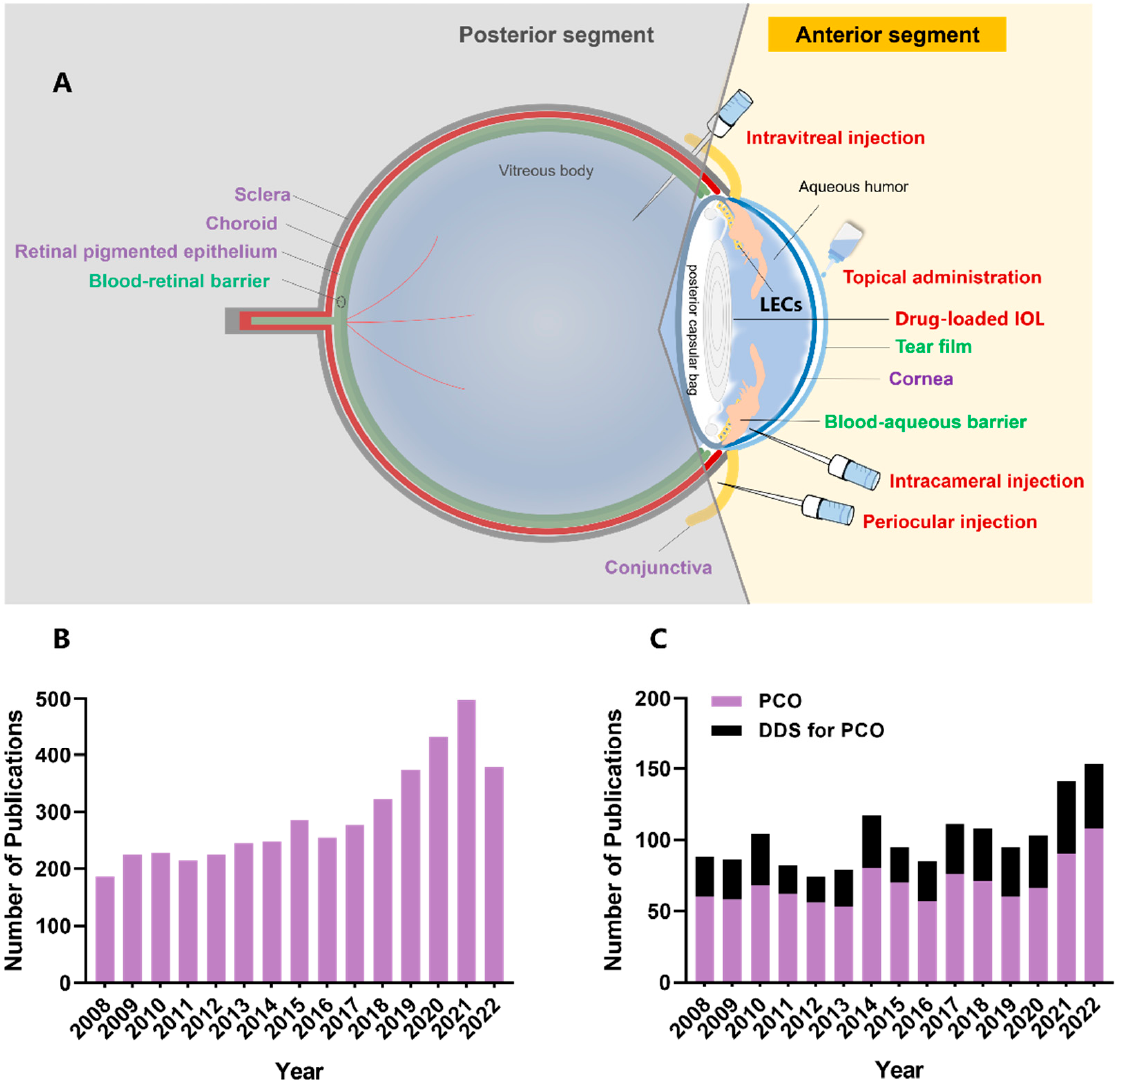
Figure 1. DDSs used for the anterior segment of the eye. ( A ) Ocular barriers to pharmacological agents and common routes of administration. Intricate ocular barriers physically and physiologically reduce intraocular drug bioavailability. The static barriers (purple colored text, including the cornea, conjunctiva, sclera, choroid and retinal-pigmented epithelium) prevent the drug from intraocular penetration, and the dynamic barriers (green colored text, including tear film, blood–aqueous barrier and blood–retinal barrier) lead to drug clearance. The drug can be locally administered to the anterior segment via eyedrops, injections (e.g., periocular, intracameral or intravitreal) and implants (e.g., drug-eluting IOL). ( B ) The published literature on ocular DDSs for anterior segment diseases. ( C ) The published literature on PCO and anti-PCO DDSs. The literature was searched using the database of the Web of Science Core Collection from the year 2008 to 2022. The detailed search method is presented in Tables S1–S3 of the Supplementary